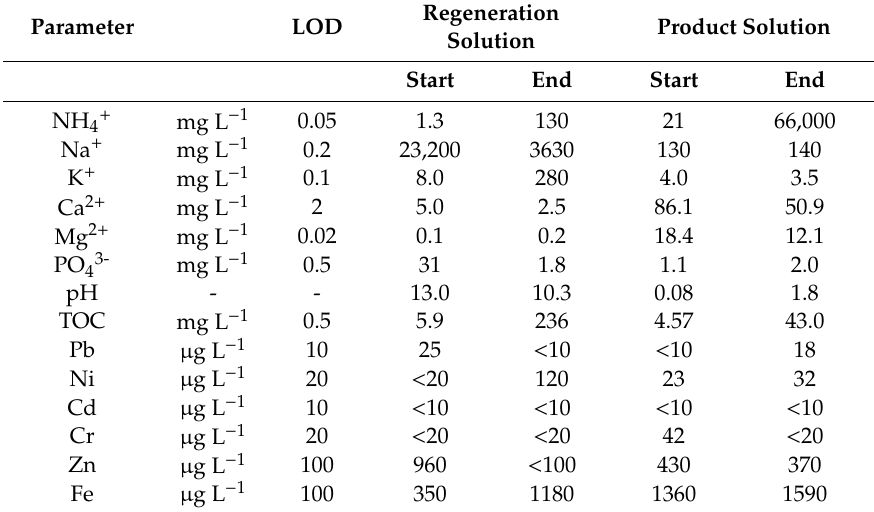
Table 3. Chemical composition of the product and regeneration solution at the beginning and end of the experimental